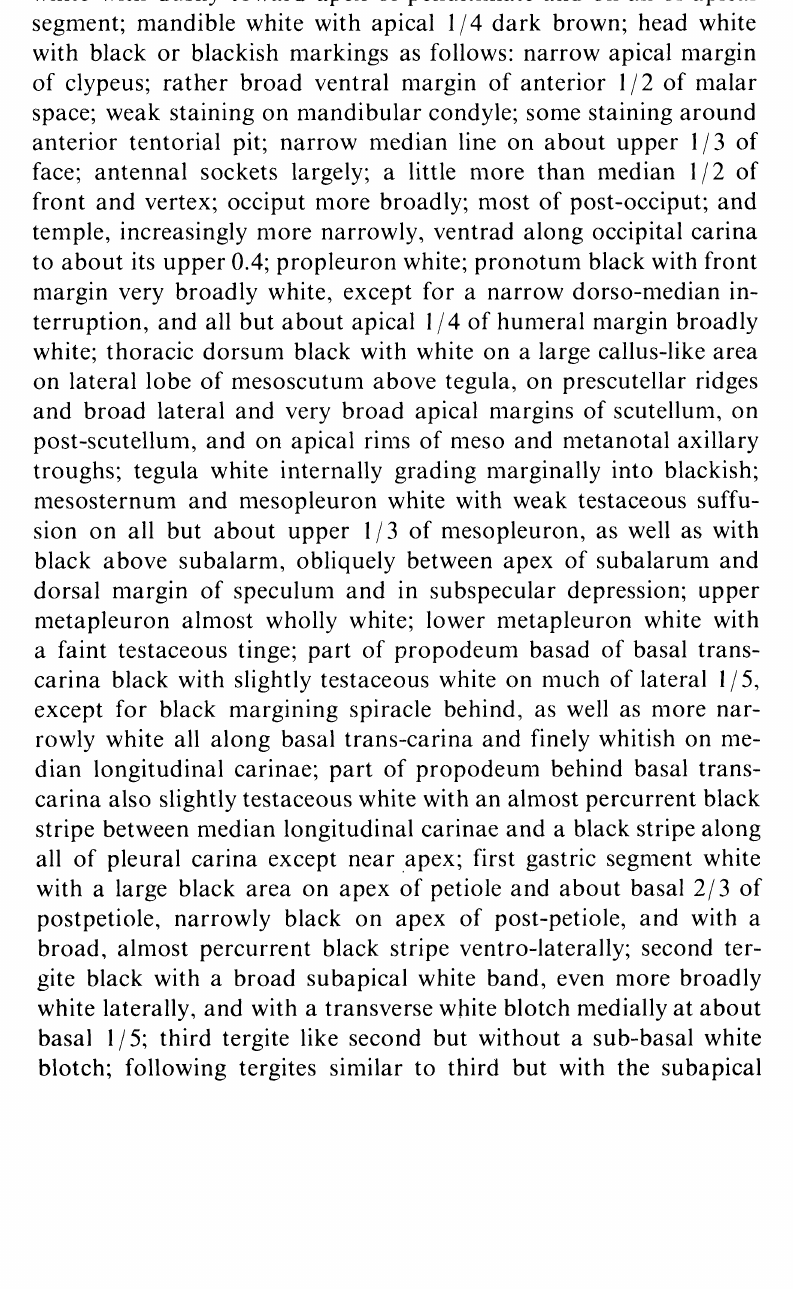
basal 1/5; third tergite like second but without a sub-basal